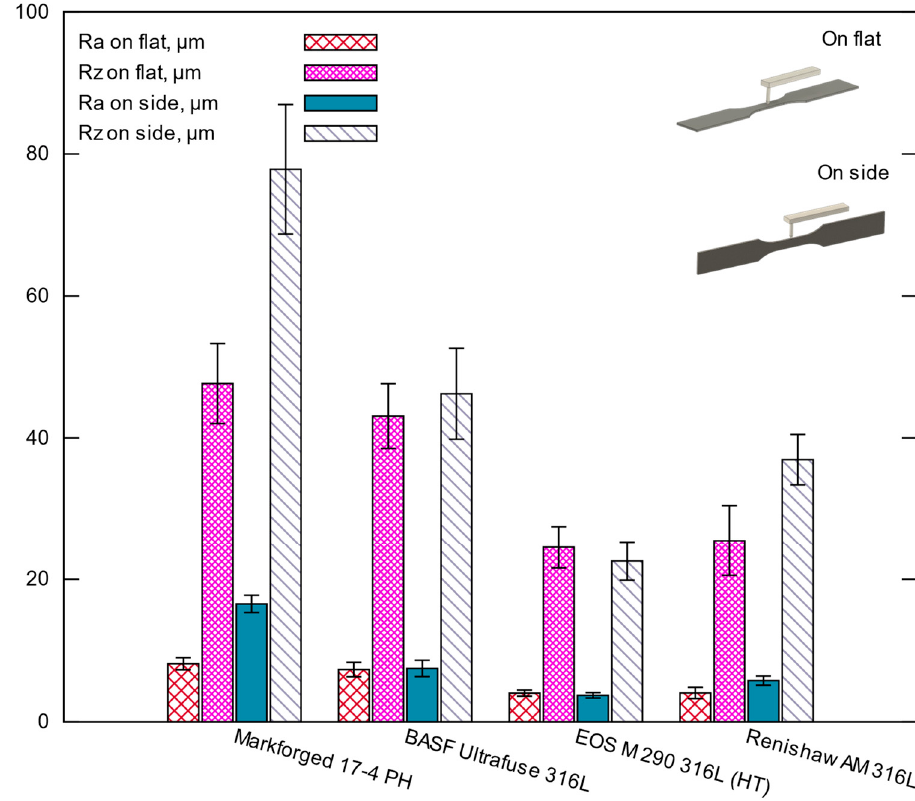
Figure 10. Results of roughness tests (mean ± standard deviation).